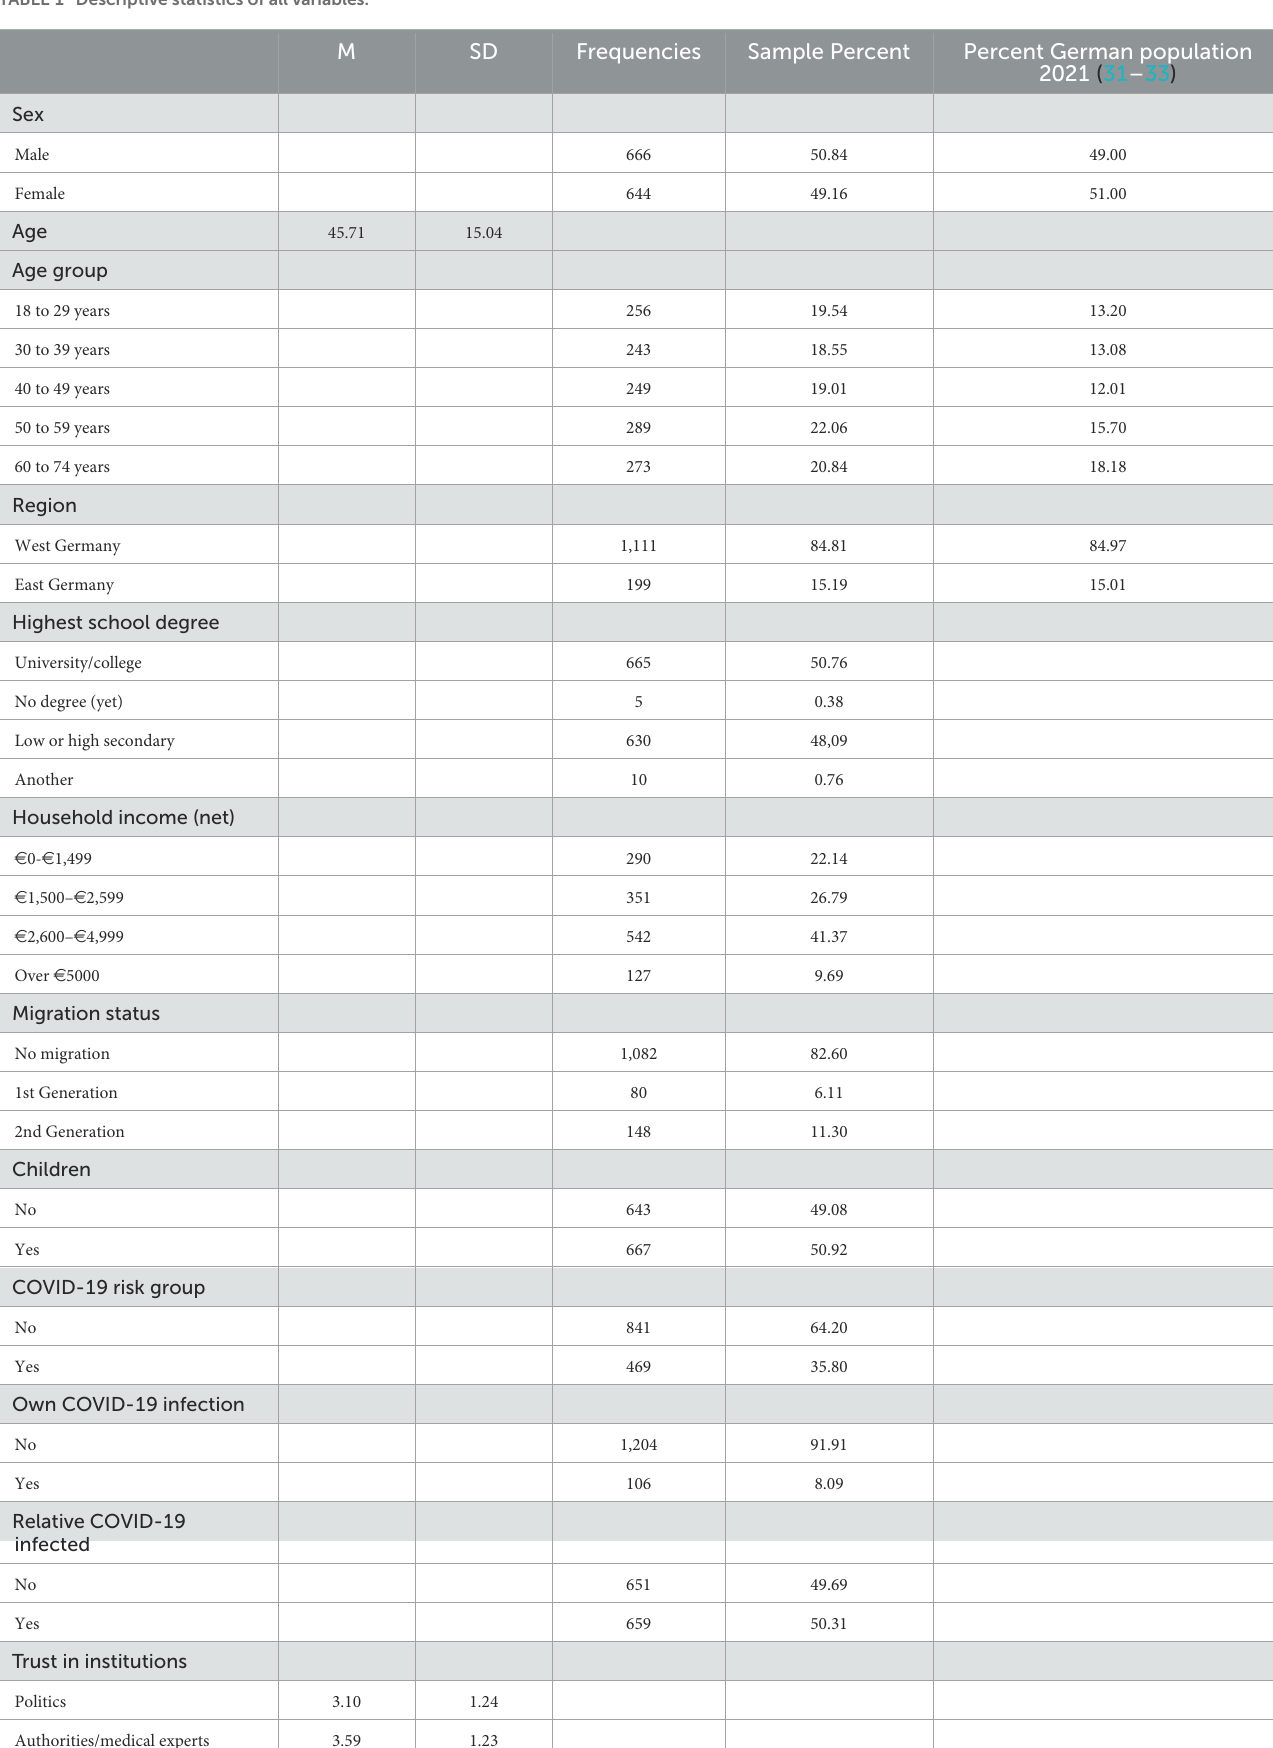
TABLE 1 Descriptive statistics of all